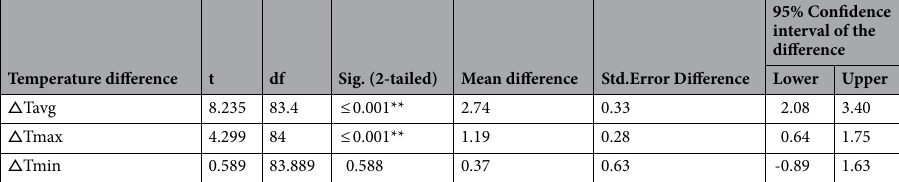
Table 4. The result of independent-samples T test. **Significant